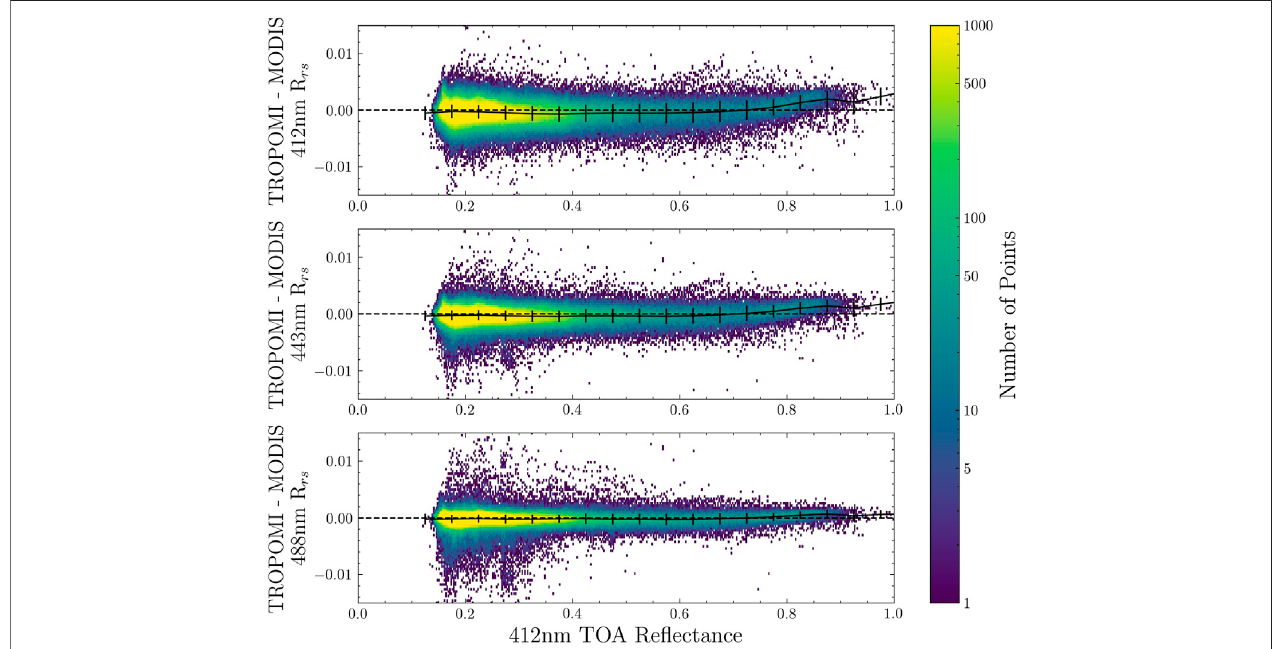
FIGURE 9 | Difference on 15 October 2020 between TROPOMI and MODIS Rrs at 412 nm (top), 443 nm (middle), and 488 nm (bottom) as a function of 412 nm TOA re fl ectance. The black line represents the mean error with the error bars showing +/ − 1 standard deviation. The data in this fi gure were not screened for clouds, aerosols, or